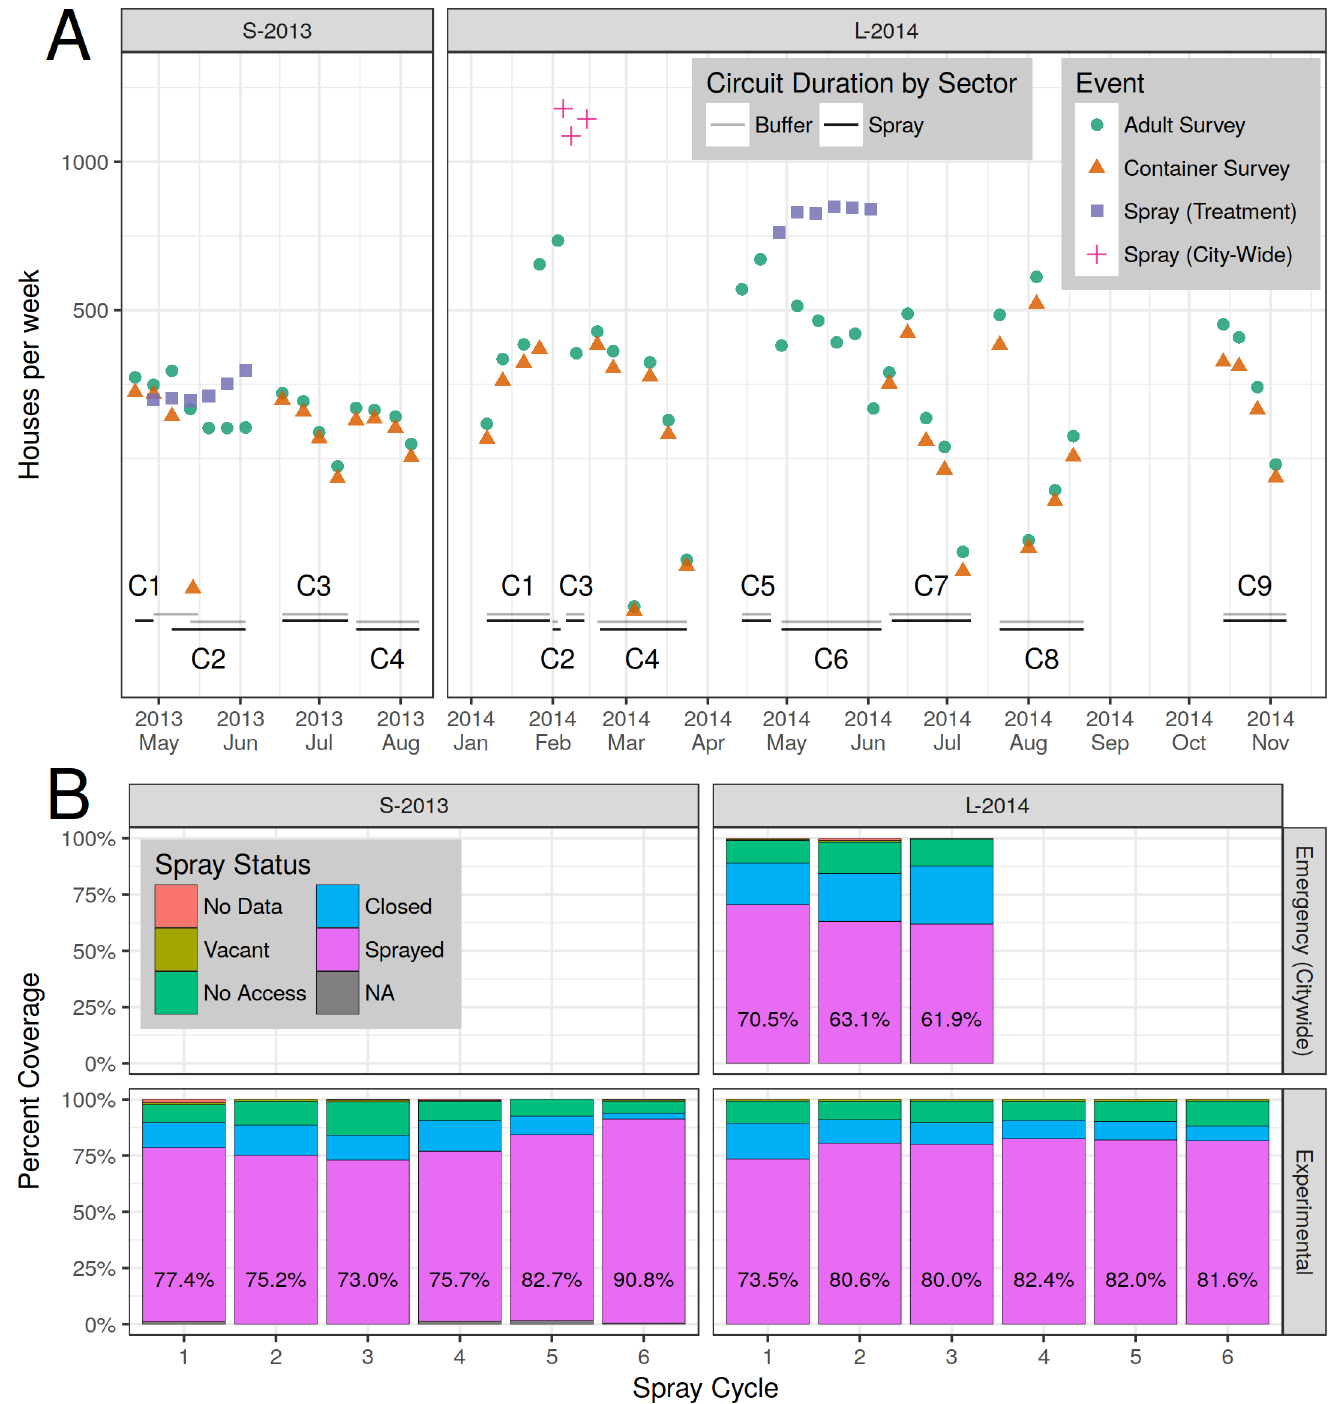
Fig 3. Sampling and spraying. (A) Number of houses per week sprayed and/or surveyed. Circuits are labeled (e.g., C1), with date ranges shown by horizontal bars. Containers were not surveyed during spray periods. The first two emergency (citywide) spray events (red +) occurred within the same calendar week, but are plotted separately here. (B) Spray coverage by spray cycle. Percent houses sprayed is shown in text. Top row: emergency (citywide) spraying. Bottom row: experimental spraying.